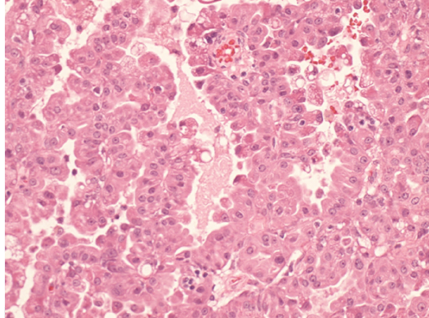
Figure 3: The microscopic examination shows atypical acinar architecture.